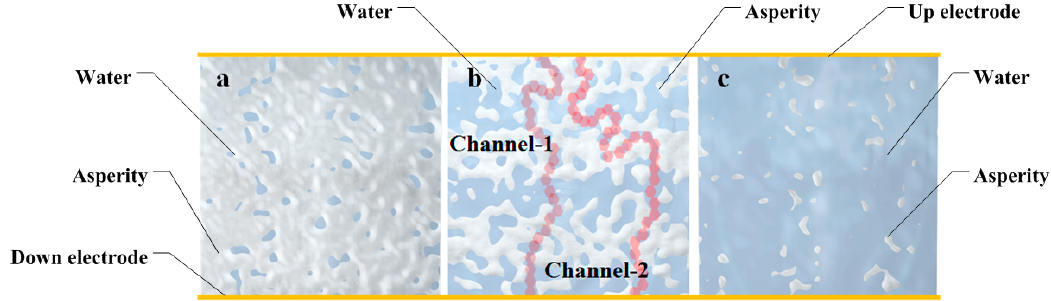
Figure 6. Water adsorption process on a rough surface. ( a ) Adsorption in low humidity; ( b ) Discharge channels forming; ( c ) Water film forming.